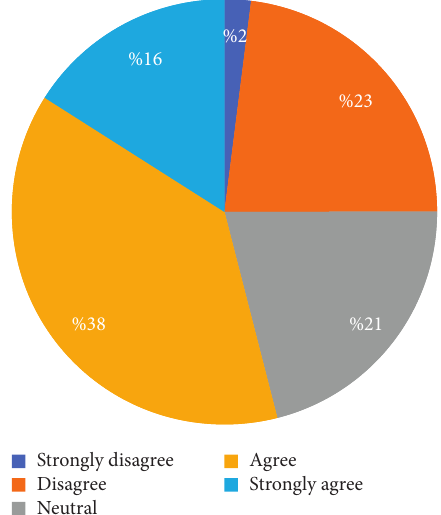
Figure 6: Q4: I think applying open data in my company will affect the productivity process upwards.